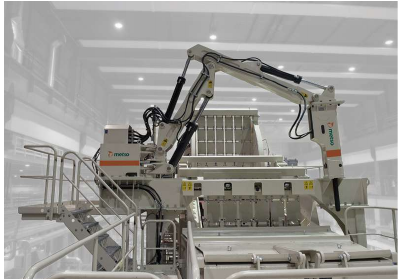
Figure 10. New crushing hammer on the first in the technological chain sieving screen (METSO